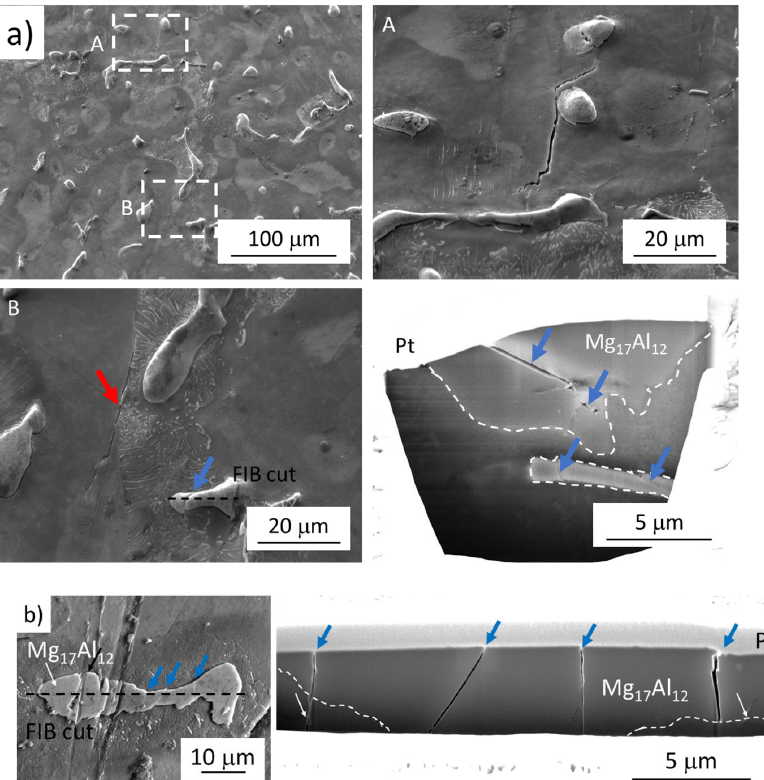
Figure 7. FIB cuts through the Mg 17 Al 12 particles revealing the fatigue crack propagation mechanism. Blue arrows indicate cracks in the particles. Red arrows indicate the cracks in the solid solution matrix. The Mg 17 Al 12 particle is outlined by white dashed line on FIB cuts; ( a ) LCF region; σ a = 120 MPa, N f = 4,088 cycles, f = 10 Hz; ( b ) VHCF region; σ a = 65 MPa, N f = 141,804,000 cycles, f = 20 kHz.